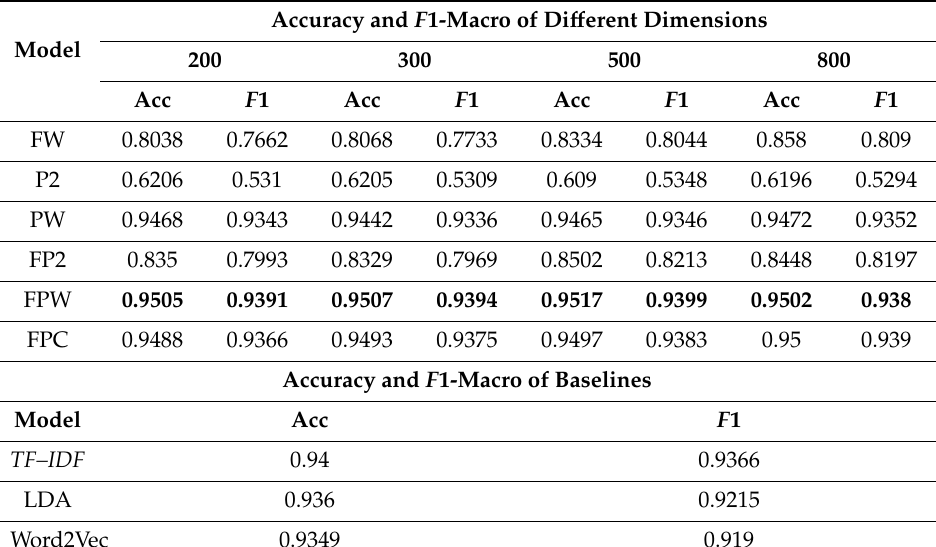
Table 4. Results of Amazon_6 in four classes for 5705 texts by